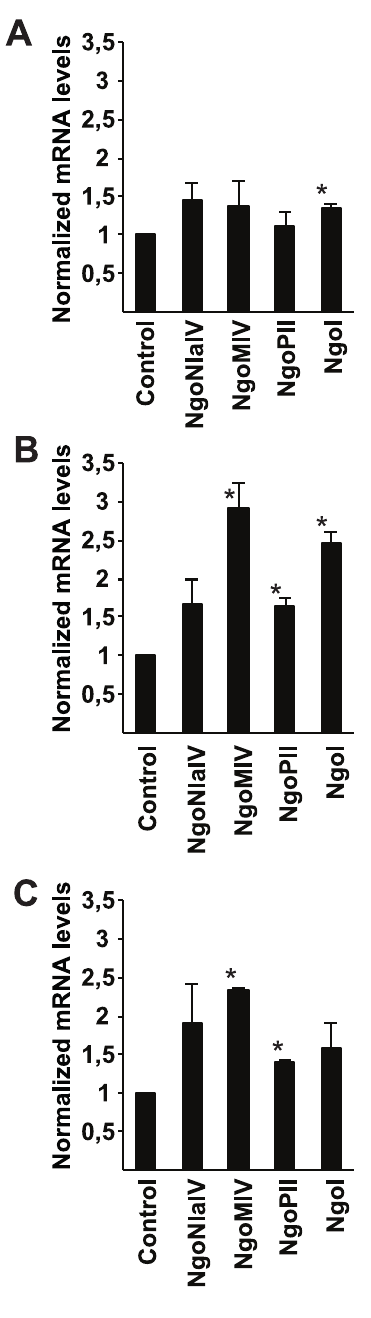
Figure 1. Bacterial restriction endonucleases are upregulated upon adhesion and invasion. Cells were infected with N. gonorrhoeae strain MS11P + for 2, 7, and 24 h. Bacteria alone (without cells) were used as a control. qPCR was conducted on bacterial DNA, and Ef-Tu1 was used as internal standard. Average normalized mRNA levels of NgoNlaIV , NgoMIV , NgoPII , and NgoI following A. 2 h. B. 7 h, and C. 24 h of infection in 2 independent experiments are shown. Data were analyzed using a paired 2-tailed Student’s t - test. Error bars represent S.E.M. (* p , 0.05).